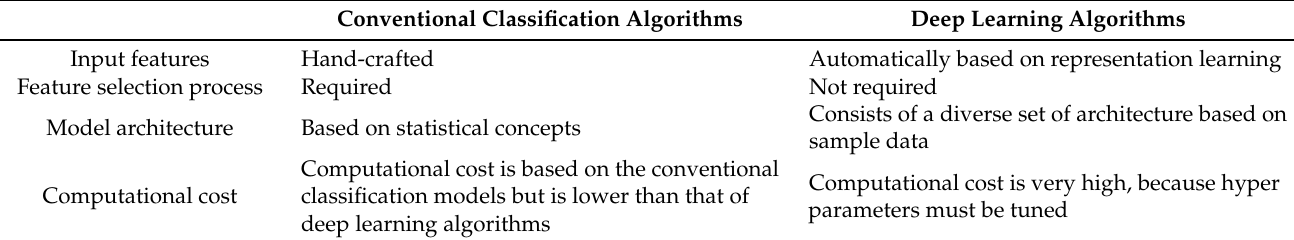
Table 1. Brief comparison of conventional classification algorithms and deep learning